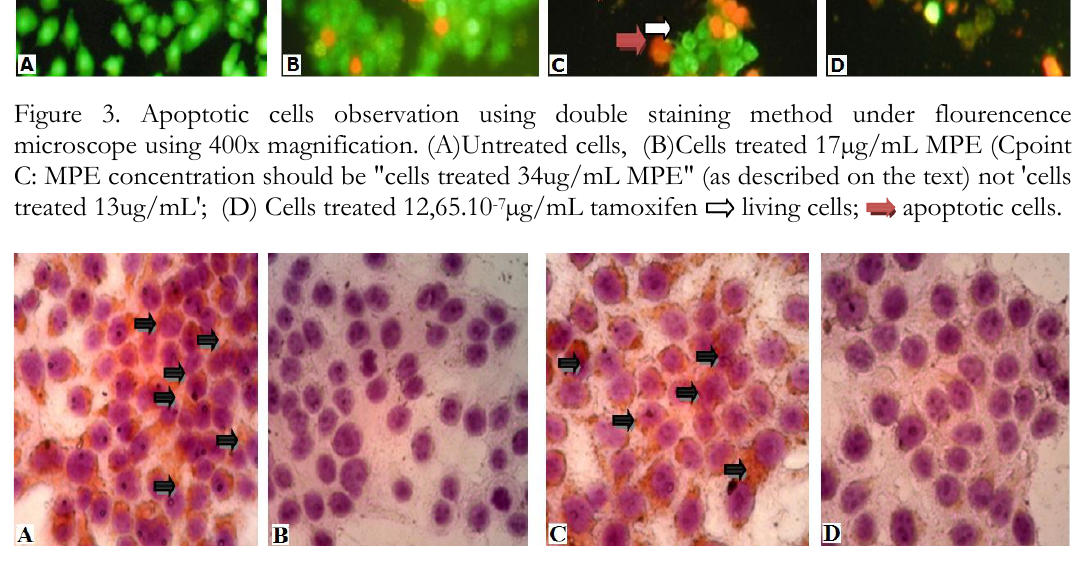
Figure 4. The observation of ER-α expression using immunocytochemistry method under light microscope using 400x magnification. (A)Untreated cells, (B) Untreated cells without antibody (C) MPE 17µg/mL treated cells (D) tamoxifen expressed